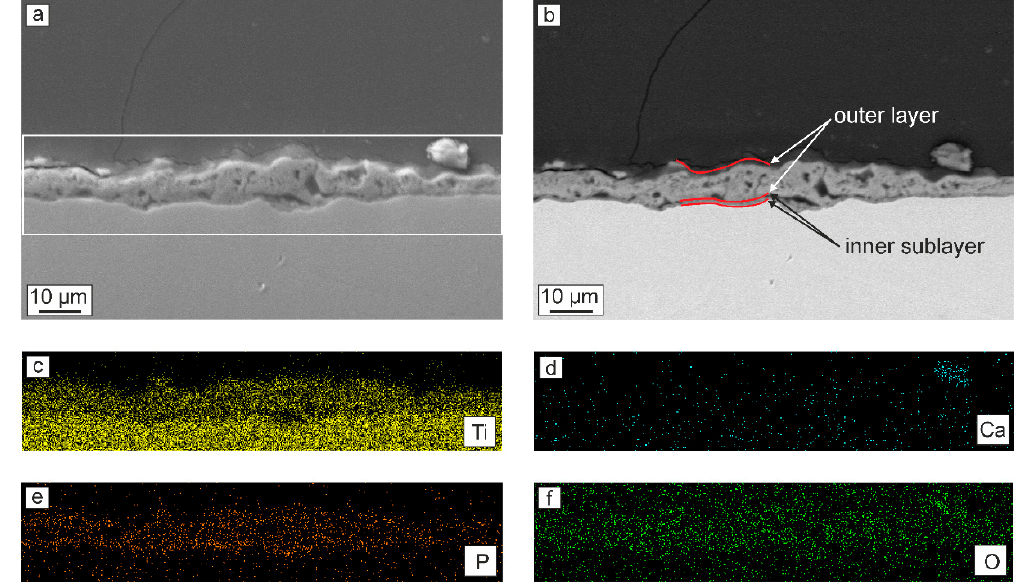
Figure 2. Cross-sectional SEM-images of the PEO-coating in ( a ) secondary and ( b ) backscattered electrons and a map of the elements distribution: ( c ) titanium, ( d ) calcium, ( e ) phosphorus, and ( f ) oxygen.